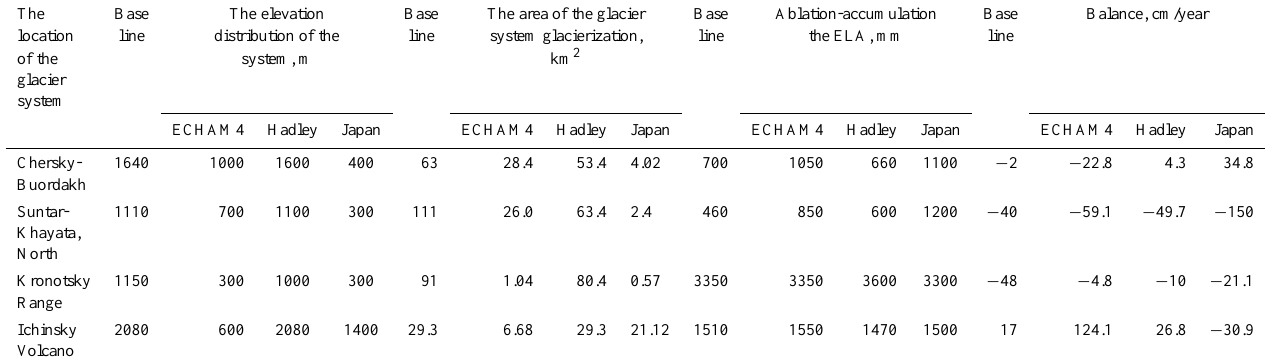
Table 3. The change of the main characteristics for key glacier systems by three GCMs to 2040–2069. Non-linear distribution of ice via altitude while glacier